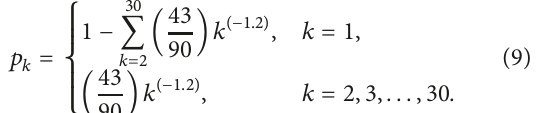
100 Monte Carlo simulations for the Power-law